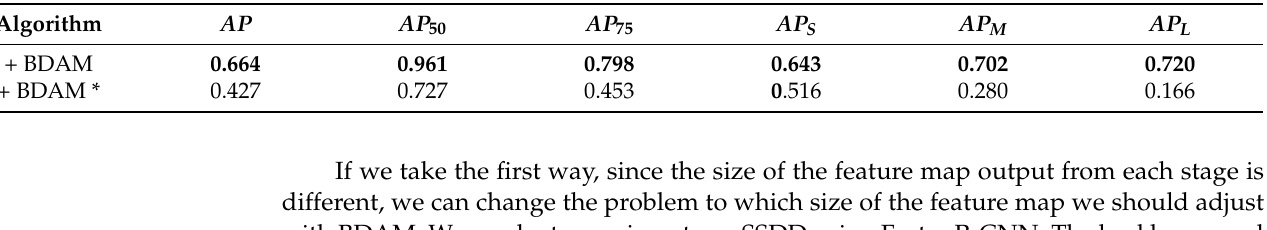
Table 9. Performance of insertion in block and insertion in stage on Faster R-CNN. Bolded data represent the best and underlined data represent the second best.